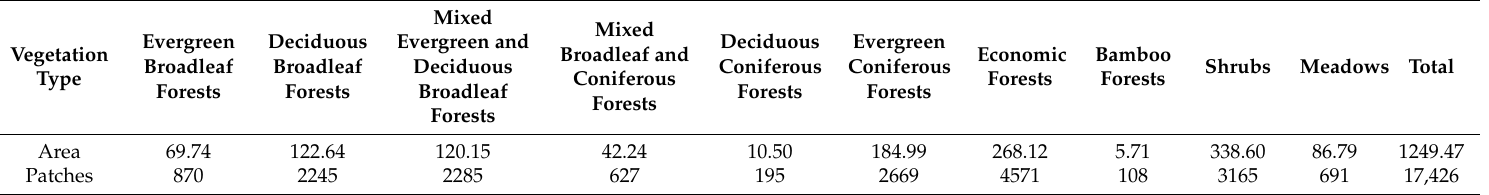
Table 1. The areas of different damaged vegetation types in nine worst-hit cities and counties (km 2 ): Among all the vegetation types, we defined economic forests as the plantation that produces fresh or dry fruits, edible oils, beverages, spices, industrial raw materials, and medicinal materials.